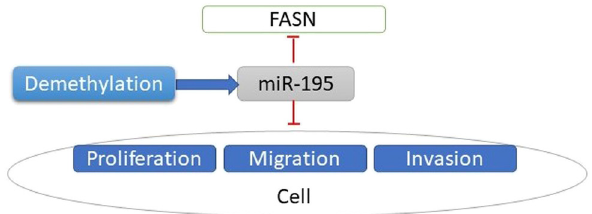
Figure 6: Flow chart of the summary of the main contents. Decreased expression of miR - 195 mediated by hypermethylation promotes